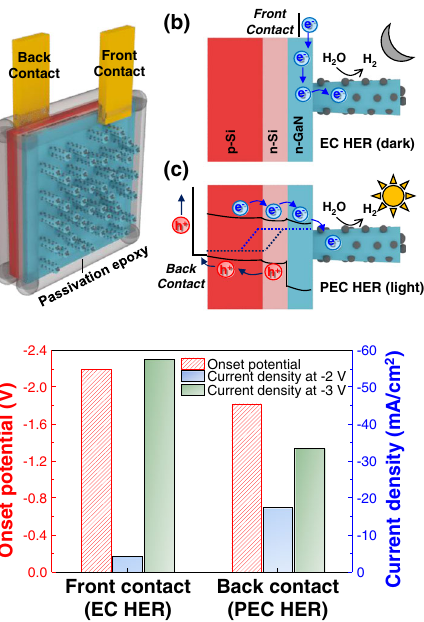
Fig. 5 | PEC/EC switchable electrode. a Schematic of switchable dual contact electrode.ThefrontcontactisplacedonthefrontsideofGaNnanowires(NWs)and the back contact is placed on the back side of n + -p Si wafer. GaIn eutectic was sandwiched between the Cu contacts and the substrate for Ohmic connection. Illustrationsofworkingprinciplesof b frontcontactforelectrochemicalHERunder darkand c backcontactforphotoelectrochemicalHERunderlight. d LSVcurvesof